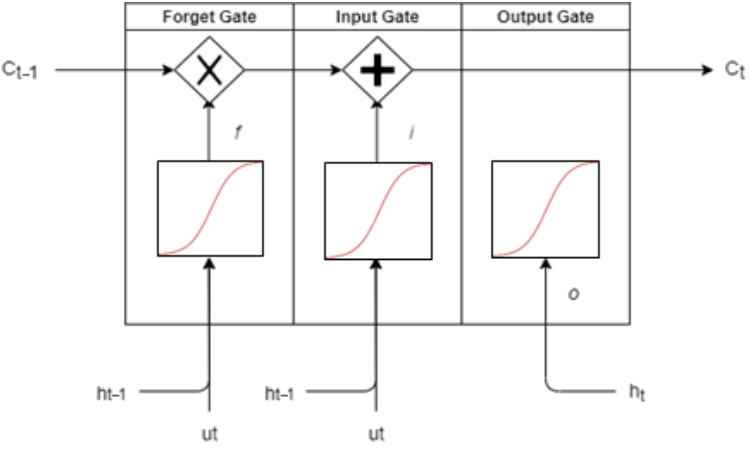
Figure 3. LSTM memory cell.